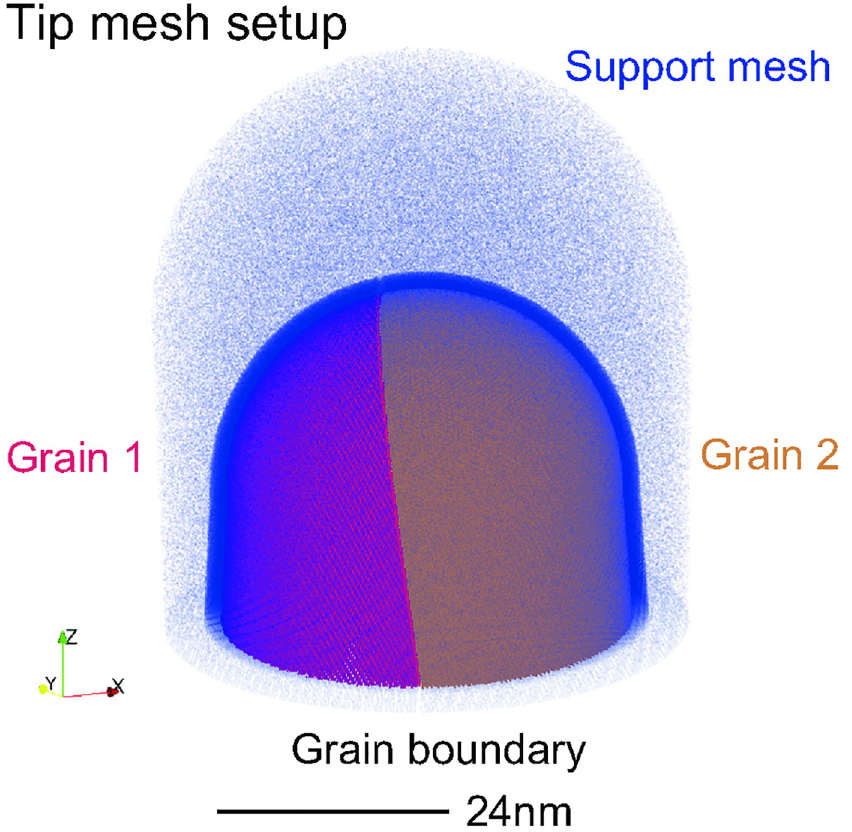
Fig 3. The experimentally informed simulation setup for direct comparison with